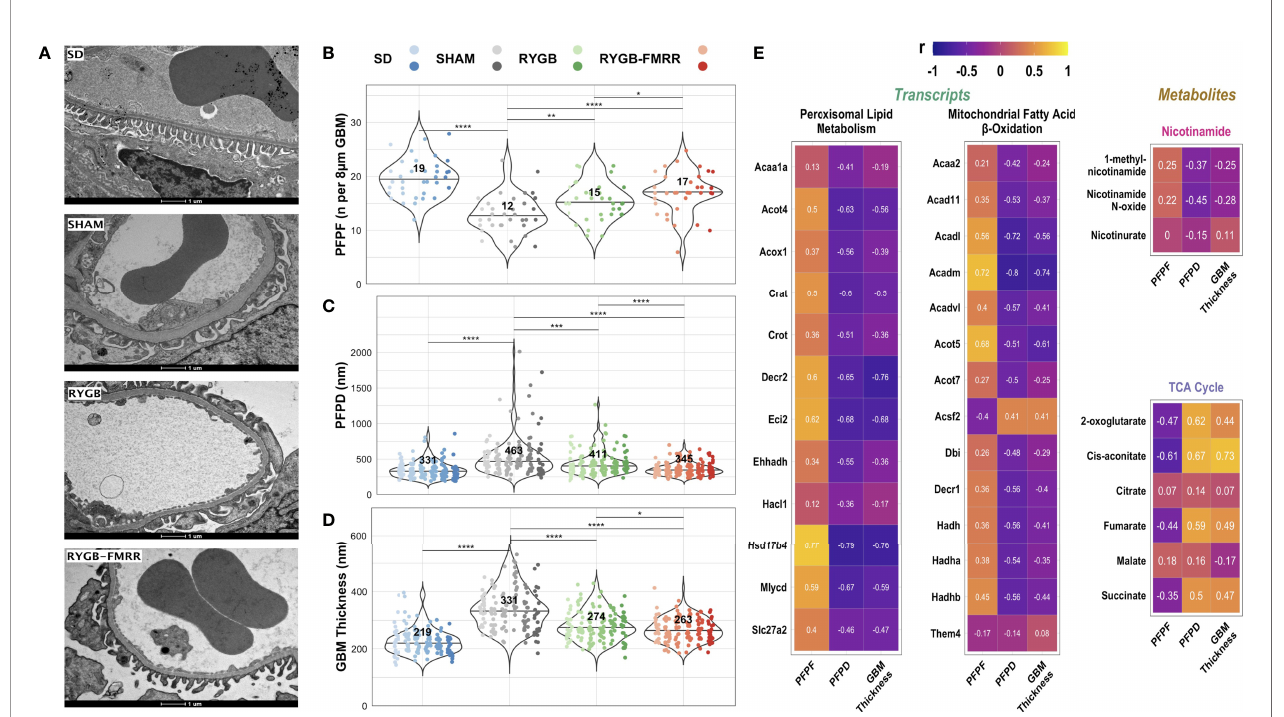
FIGURE 9 | Changes in glomerular ultrastructure and their relationship to renal cortical FAO transcripts and urinary nicotinamide and TCA cycle metabolites. (A) Representative images (9900x, scale bar 1µm) of transmission electron microscopy images of glomerular capillary loops from the four experimental groups. (B – D) Podocyte foot process frequency (per 8µm of glomerular basement membrane length), podocyte foot process diameter (nm), and glomerular basement membrane thickness (nm) were quanti fi ed using transmission electron microscopy images from 6 animals per group. Six determinations of podocyte foot process frequency were made per animal, while twenty-four determinations of podocyte foot process diameter and glomerular basement membrane thickness were made per animal. Data are plotted as violin plots with individual glomerular measurements superimposed. Within each group, each animal is identi fi ed as its own column of dots with a unique colour shade. Median group values are identi fi ed by the horizontal black line in each violin and printed on each violin. Statistical signi fi cance of between-group differences derived from multiplicity-corrected Wilcoxon rank-sum tests is presented. Statistical signi fi cance is denoted as follows: ns = not signi fi cant; * = p <0.05; ** = p <0.01; *** = p <0.001; **** = p <0.0001. (E) Correlation plots highlighting Pearson correlation r values for glomerular ultrastructure (podocyte foot process frequency, podocyte foot process diameter, and glomerular basement membrane thickness) correlations with renal cortical transcripts and urinary metabolites. Regularized log-transformed gene expression counts were used for gene-structure correlations. Transcripts plotted are those which resulted in enrichment of peroxisomal and mitochondrial lipid metabolism pathways in RYGB-FMRR rats (also highlighted in the circular network plot in Figure 2D ). PQN-normalized urinary 1 H-NMR peaks from samples obtained at 4 weeks after intervention were used for metabolite-structure correlations. Metabolites involved in nicotinamide metabolism (PPAR a biomarkers) and TCA cycle intermediates, many of which were differentially abundant between RYGB-FMRR and RYGB rats, are plotted. Individual cells in the correlation plots are scaled by colour indicating strength and directionality of the correlation. GBM, glomerular basement membrane; PFPD, podocyte foot process diameter; PFPF, podocyte foot process frequency; PPAR a , peroxisome proliferator-activated receptor-alpha; RYGB, Roux-en-Y gastric bypass; RYGB-FMRR, Roux-en-Y gastric bypass plus feno fi brate, metformin, ramipril, and rosuvastatin; SD, Sprague Dawley; SHAM, sham surgery (laparotomy); TCA, tricarboxylic